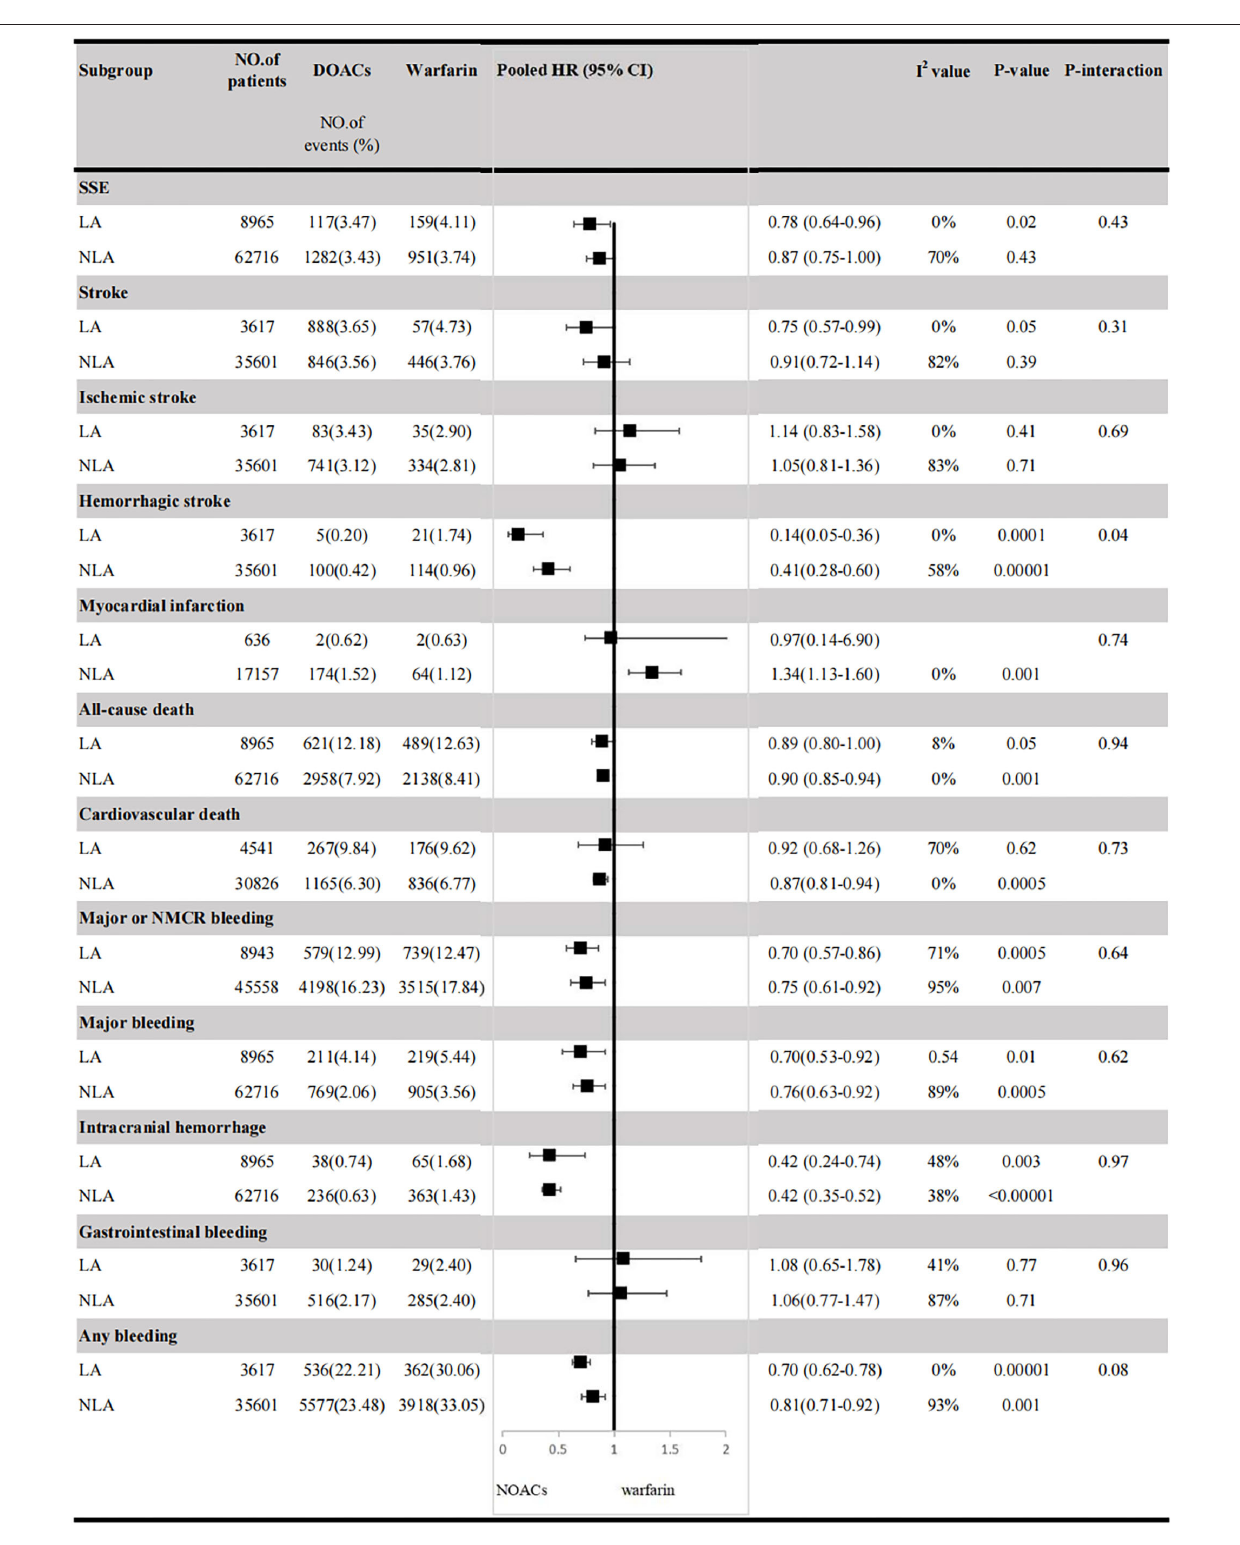
Frontiers in Cardiovascular Medicine |